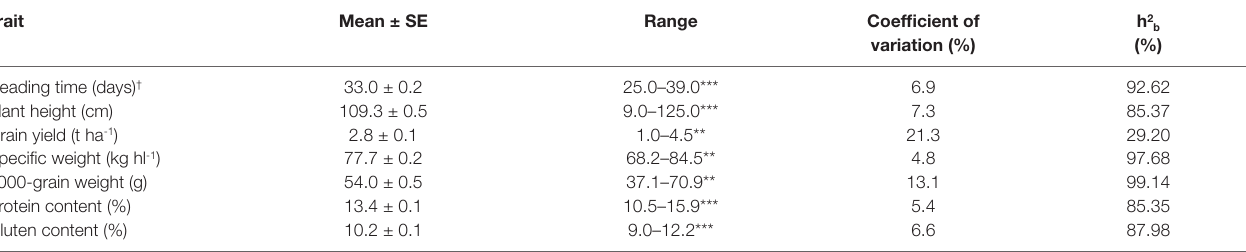
TABLe 2 | Mean, standard error (SE), range, coefficient of variation and broad-sense heritability (h 2 b ) for the seven agronomic traits of the 77 Khorasan accessions grown at Foggia (Italy) over the three growing seasons (from 2005 to 2007). Mean ±